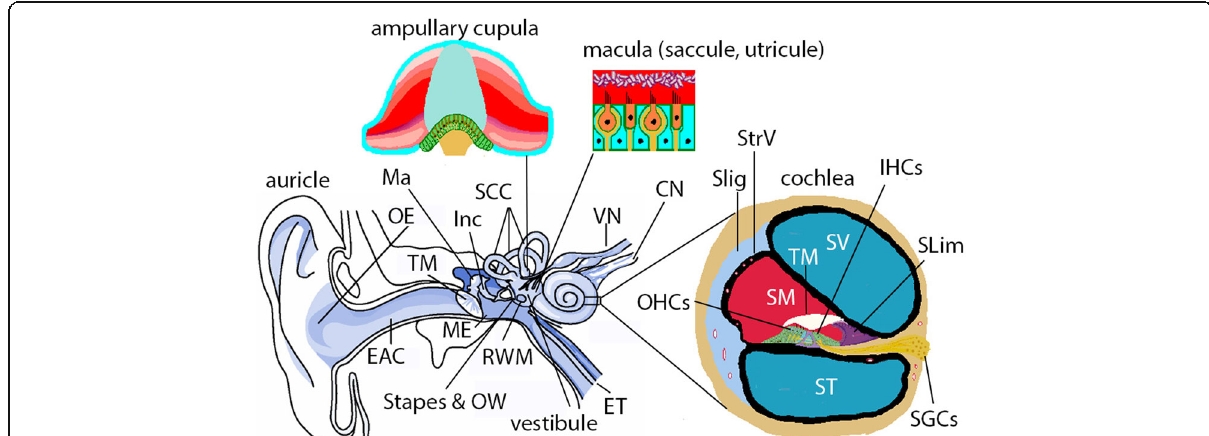
Fig. 1 Illustration of the mammalian ear. The mammalian ear (including humans and rats) is composed of outer, middle, and inner ears. The outer ear ( OE ) is composed of auricle and external auditory canal ( EAC ). The middle ear ( ME ) is composed of the tympanic membrane ( TM ) and the cavity that houses the ossicular chain, including the malleus ( Ma ), incus ( Inc ), and stapes. The middle ear cavity is an extension of the nasopharynx via the Eustachian tube ( ET ) and communicates with the inner ear through the oval window ( OW ) and round window membrane ( RWM ). The inner ear is composed of cochlea and vestibular system. The cochlea is the sensory organ for hearing and has three chambers, i.e., the perilymphatic compartments of scala tympani ( ST ) and scala vestibuli ( SV ), and the endolymphatic compartment of scala media ( SM ). On the lateral wall of SM, there are the stria vascularis ( StrV ) and spiral ligament ( SLig ). On the bottom of SM, there are organ of Cortis that contains inner hair cells ( IHCs ) and outer hair cells ( OHCs ), tectorial membrane ( TM ), and spiral limbus ( Slim ). The spiral ganglion cells ( SGCs ) fire an action potential corresponding to the mechano-electrical transduction of the hair cells and supply all of the brain ’ s auditory input. The vestibular system is responsible for balance and is composed of three semicircular canals ( SCC ) and vestibule. The ampullary cupula within the SCC detect rotational accelerations and the macula within the saccule and utricule of the vestibule detect linear accelerations. CN cochlear nerve, SP spiral prominence, VN vestibular nerve, VS vas spiralis. (adapted from Zou J. Focal Drug Delivery in Inner Ear Therapy: in Focal Controlled Drug Delivery. Editors: Domb AJ and Khan W. Springer, London, UK. ISBN: 978-1-4614-9433-1, 2014;